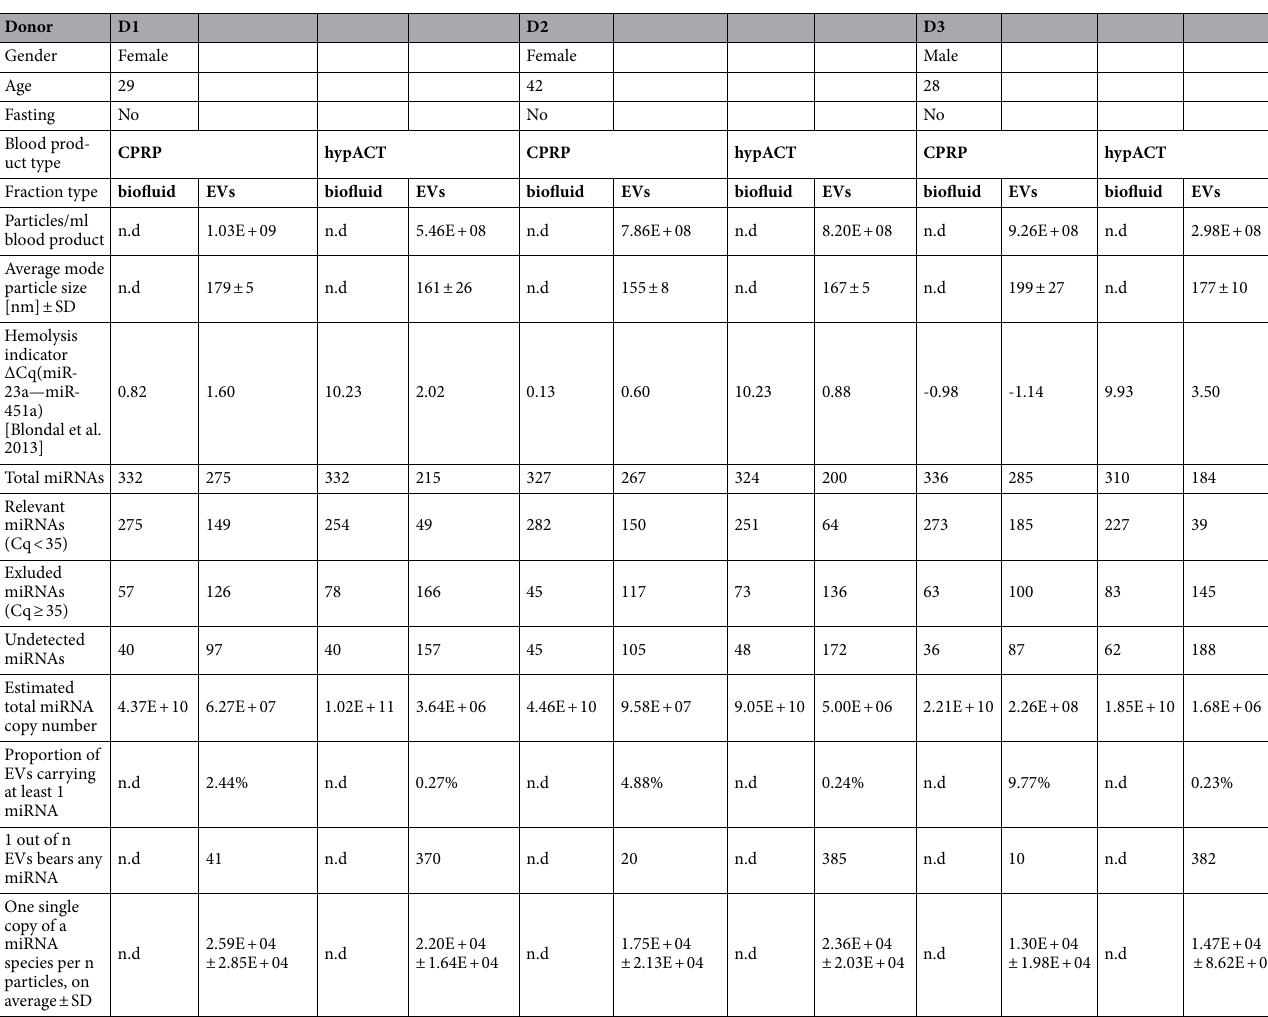
Table 1. Donor characteristics and sample details used for miRNA profile characterisation. Concentrations and mode sizes of EVs were determined in SEC fractions via NTA before final pooling via UC. n.d. not